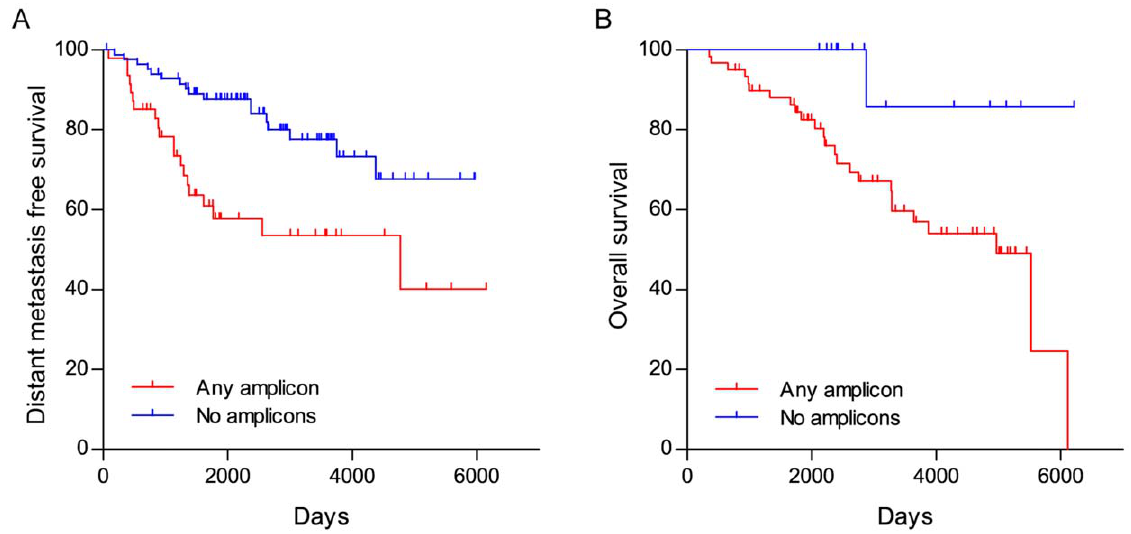
Figure 3. Analysis of intermediate grade tumors by presence of amplicons. Kaplan-Meier curves comparing distant relapse rates for intermediate grade cancers with any of the 4 amplicons versus cancers with none of the amplicons (A) in the training set GSE6532 (HR =3.22, 95% CI =1.6–6.5; P =0.0012). Also shown Kaplan-Meier curves comparing overall survival for intermediate grade cancers with any of the 4 amplicons versus cancers with none of the amplicons (B) in the test set GSE22133 (HR =3.01, 95% CI =1.2–7.6; P =0.0200).